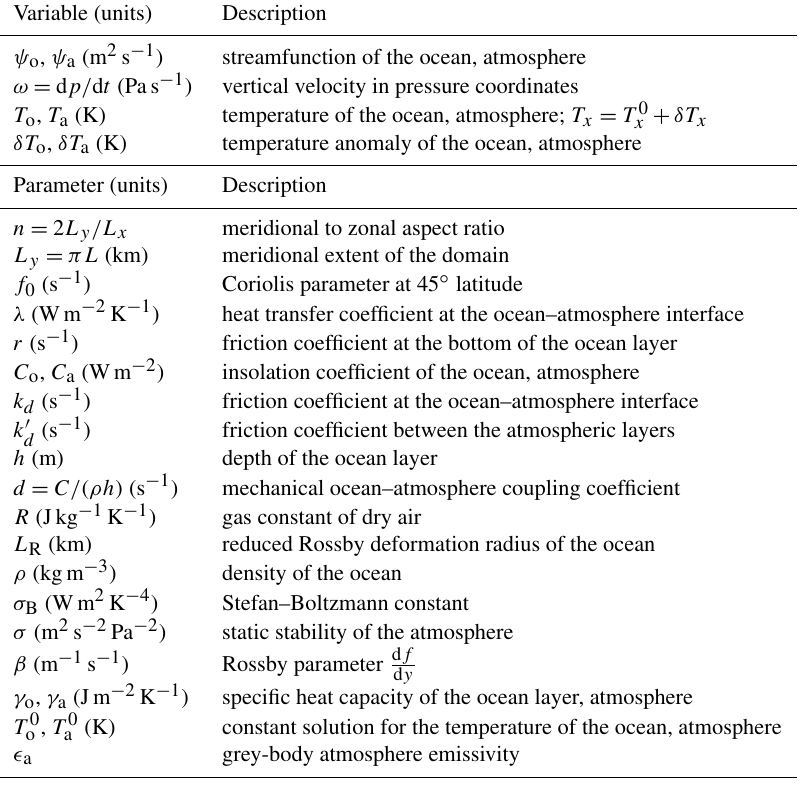
Table 2. Variables and parameters in the MAOOAM